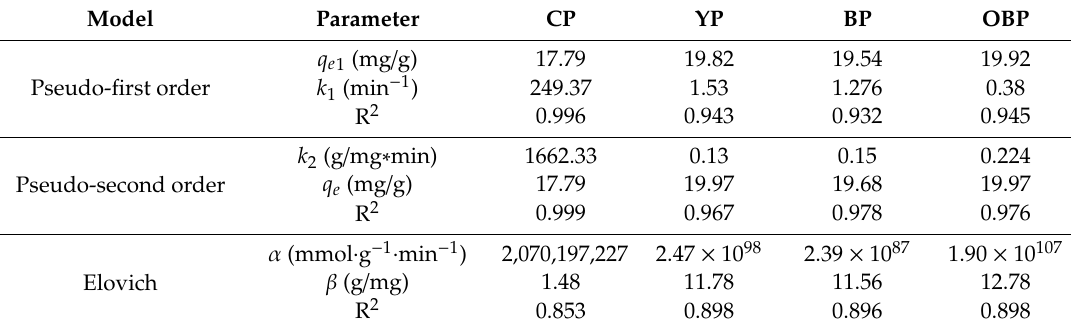
Table 6. Fitting parameters for kinetic models.